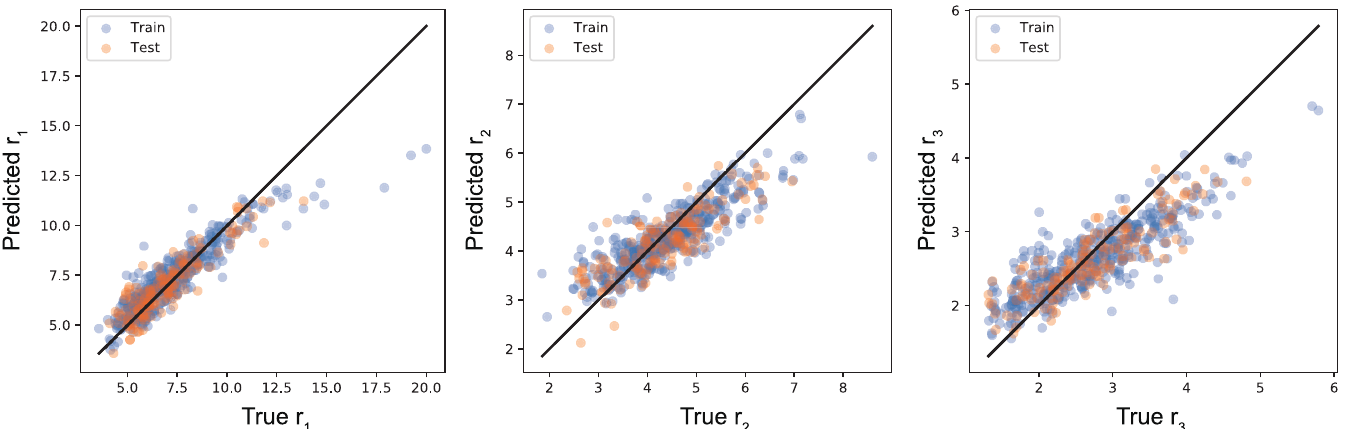
Fig 10. Prediction of the ellipsoid radii for PAs from ECFPs. The horizontal axis represents the teacher data and the vertical axis represents the predicted value. (a) r 1 . (b) r 2 . (c) r 3